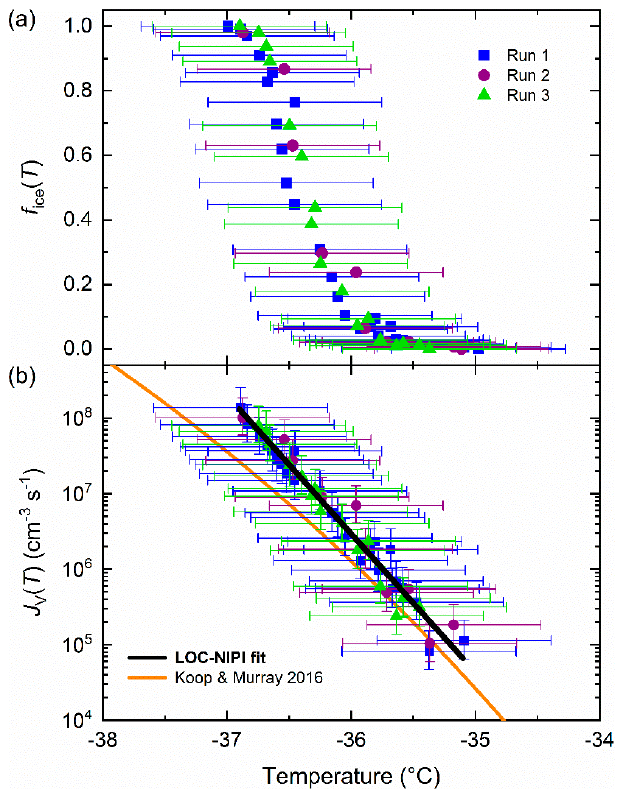
Figure 2. LOC-NIPI data for the homogeneous freezing of pure water droplets across three experi- mental runs: ( a ) The fraction frozen, f ice ( T ), of the droplet population; ( b ) the volume nucleation rate coefficient, J V ( T ), and overall fit of the data (see Table 2 for details of the applied fit), with the physically constrained CNT parameterisation of Koop and Murray [41] shown for comparison.